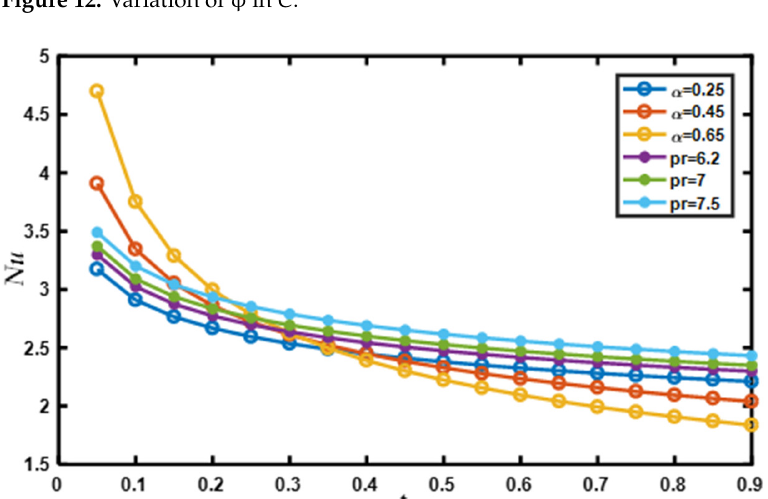
Figure 13. Variation of α , Pr in Nu .